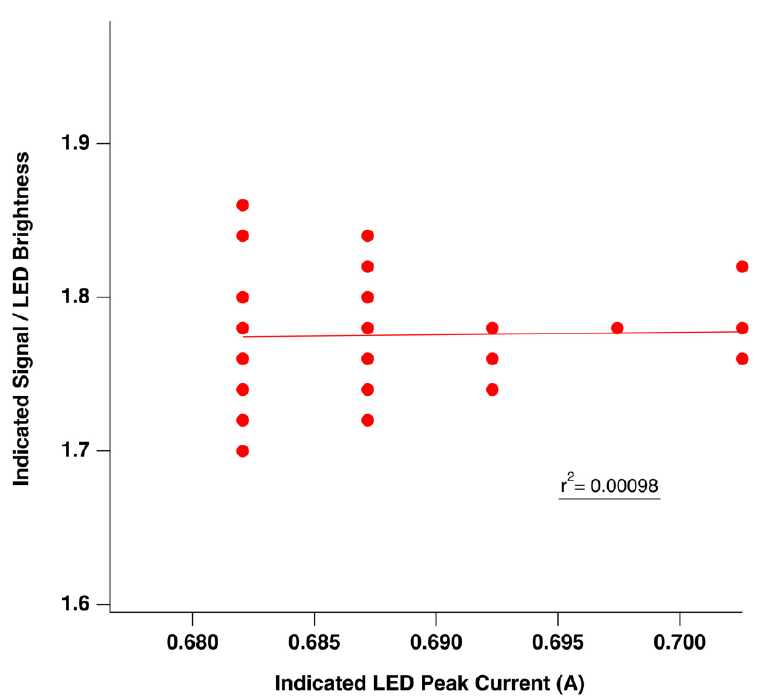
Figure 4. Plot of indicated LED brightness (signal) vs. indicated LED peak current. As R 2 between these variables was <0.001, no correlation was observed, indicating that LED drive current is not useful to correct for pulse-to-pulse variability in Sharp dust sensors.